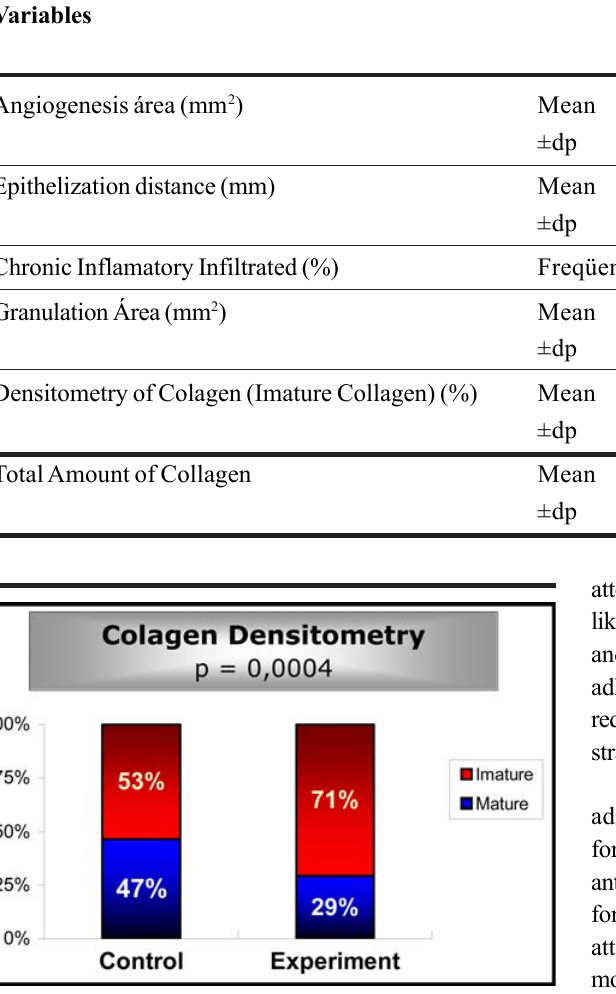
TABLE 4 - Histological evaluation abstract of sections stained with HE and Sirius Red Variables